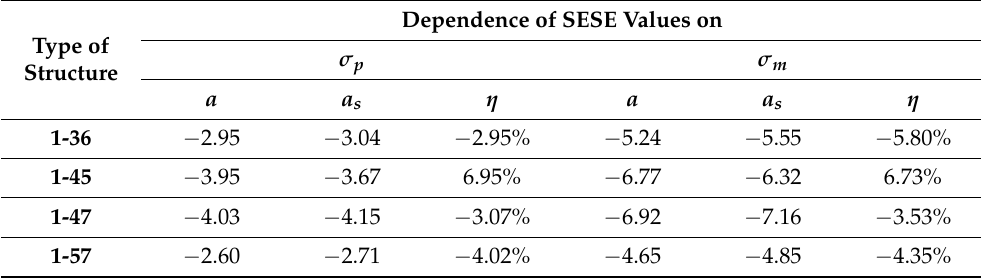
Figure 9. Comparison of dependences of SESE values on Hammett constants for p - and m -substituted benzene derivatives, σ p nd σ m , for selected types of naphthalene derivatives. Table 5. Obtained values of the slope, a , and calculated values (assuming the perfect additivity) of a s and η (relative error of additivity) for poly(CF 3 )substituted naphthalene derivatives in dependence of SESE values on Hammett